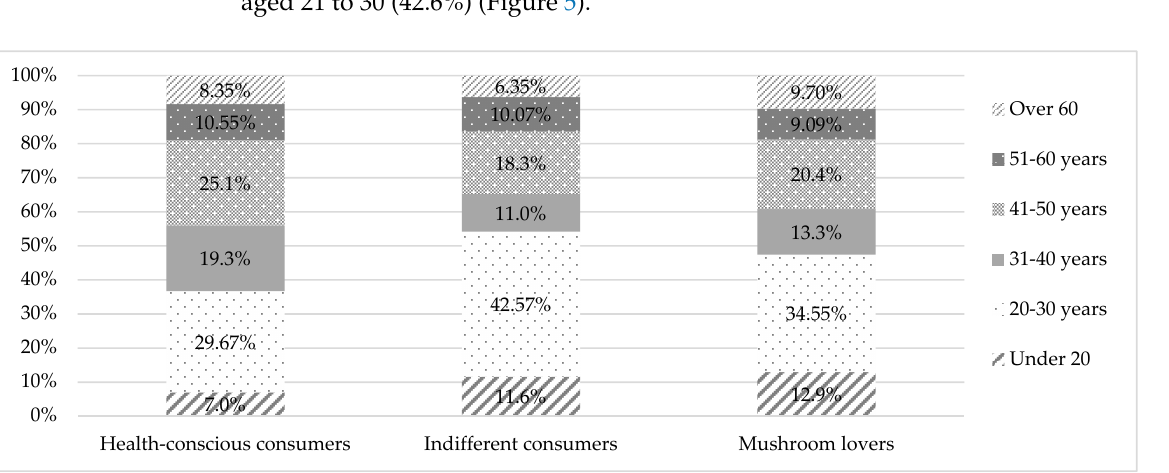
Figure 5. Age distribution within clusters generated based on the level of consciousness in mushroom consumption. The result of the Chi-square test (Chi 2 = 20.32, p = 0.002) indicates a significant rela- tionship between education and belonging to mushroom consumer clusters. Health-con- scious mushroom consumers have a lower representation of secondary school graduates than the other groups (47.3%). The proportion of higher education graduates is signifi- cantly higher (20.9%) in this cluster than in the case of indifferent consumers and average consumers (Figure 6). Figure 6. Distribution by educational level within clusters generated based on level of consciousness in mushroom con- sumption. The result of the Chi-square test (Chi 2 = 21.60, p < 0.001) confirms a significant corre- lation between marital status and belonging to mushroom consumer clusters. Health-con- scious mushroom consumers tend to be married or in a partnership (59.3%). Indifferent mushroom consumers have a higher proportion of single people than compared to the other attitude groups (43.9%) (Figure 7).